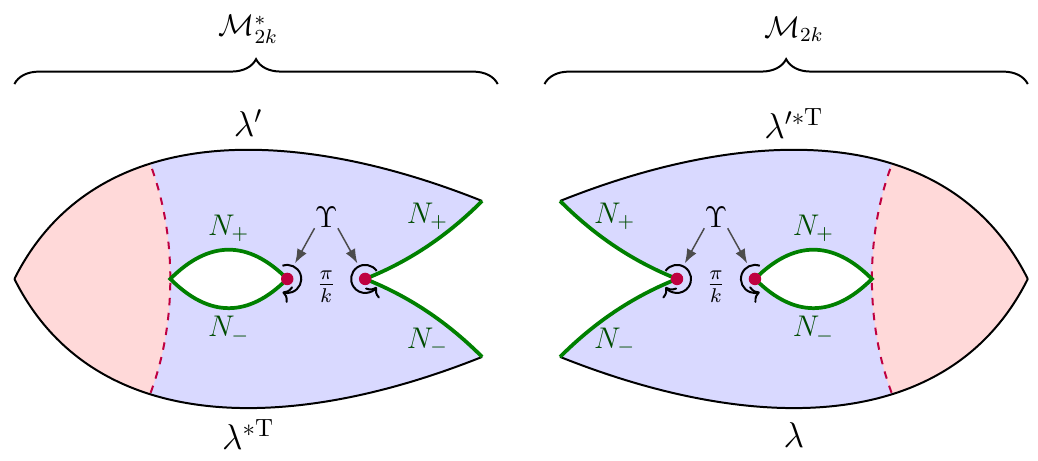
Figure 9. By cutting c M 2 k along N + ∪ N − , we get two manifolds M 2 k and M ∗ to each other by reflection and complex